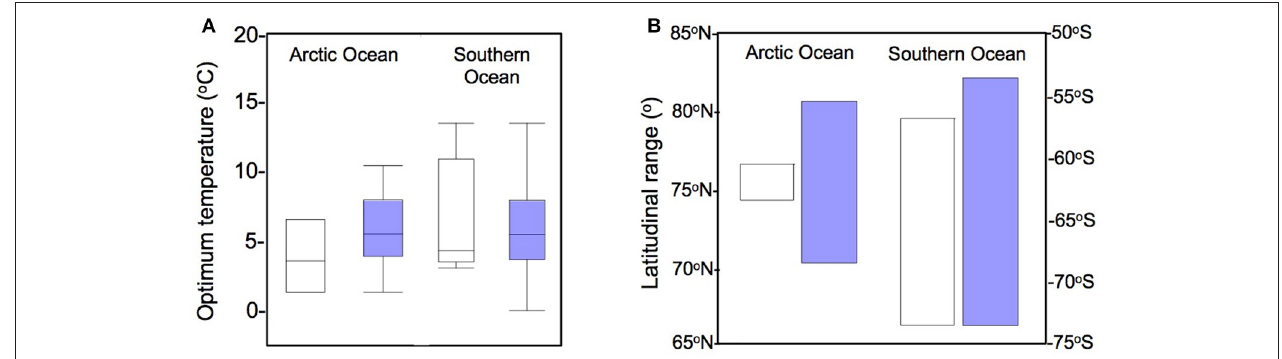
FIGURE 3 | T OPT for phytoplankton growth in polar oceans and latitudinal range of the data. (A) Distribution of the optimum temperatures for phytoplankton growth, comparing the data from Thomas et al. (2012) (white) with the dataset obtained in the present work (blue). (B) Polar latitudinal range covered in each study.